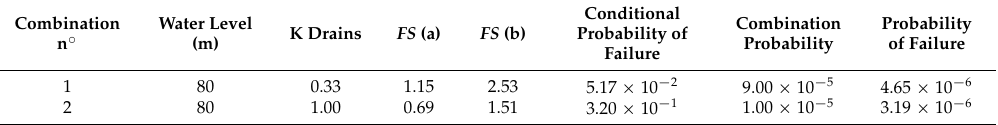
Table 5. Factor of safety and probability of failure with Approach I.